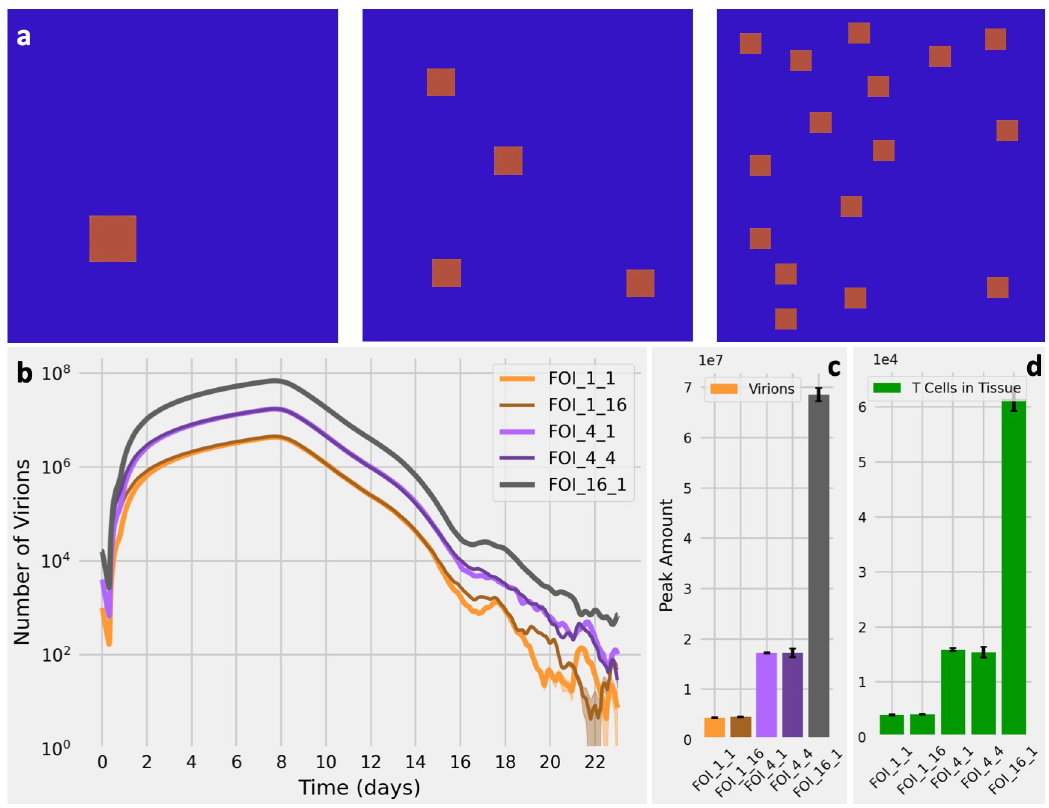
Fig 3. Effect of the number of FOI on virus and T cell dynamics. (A) Initial spatial distribution in SIMCoV for one FOI (left), four FOI (center), and 16 FOI (right). The area of each FOI is small in the simulation, but the squares shown are amplified relative to the simulation area in this image in order to make the relative sizes of the three cases visibly obvious. (B) Viral load over time given different FOI. The light orange line labelled FOI_1_1 represents one FOI initialized with a single infected cell, and the dark orange line labelled FOI_1_16 represents one FOI initialized with a cluster of 16 infected cells. Similarly, the purple lines represent four FOI, each initialized with one or four infected cells; the black line represents 16 FOI, each with one infected cell; 30 replicates with shading showing 95% CI (which is only visible at low numbers of virions). (C) Peak number of virions for different FOI with error bars showing the standard deviation for 30 replicates. There is a 3.90-fold increase from the one FOI configuration to the four FOI configuration and a further 3.99-fold increase in the 16 FOI configuration. These differences are statistically different ( p < 0.01). However, the peak virions given FOI_1_1 and FOI_1_16 are indistinguishable ( p = 0.68), as are the FOI_4_1 and FOI_4_4 cases ( p = 0.51). (D) Peak number of T cells that extravasate into lung tissue for the different FOI. Similar to panel (C) , the increase is 3.95-fold for each 4-fold increase in